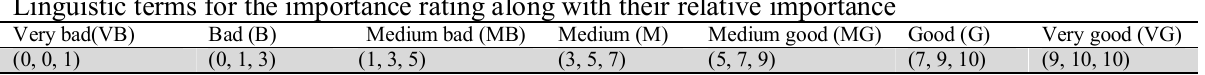
Very bad(VB) Bad (B) Medium bad